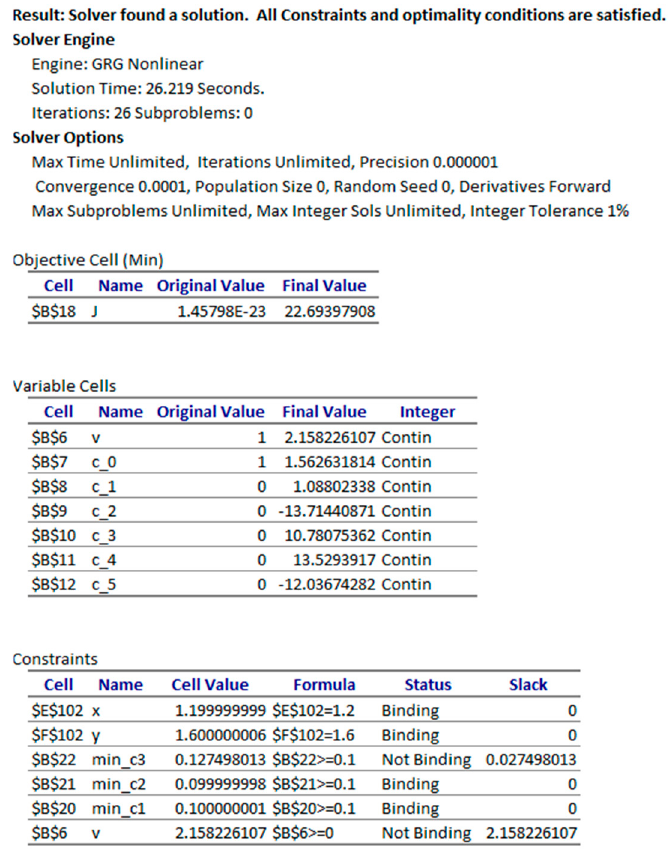
Figure 19. Answer report generated by Excel Solver for problem 3.3 with additional constraint (26).